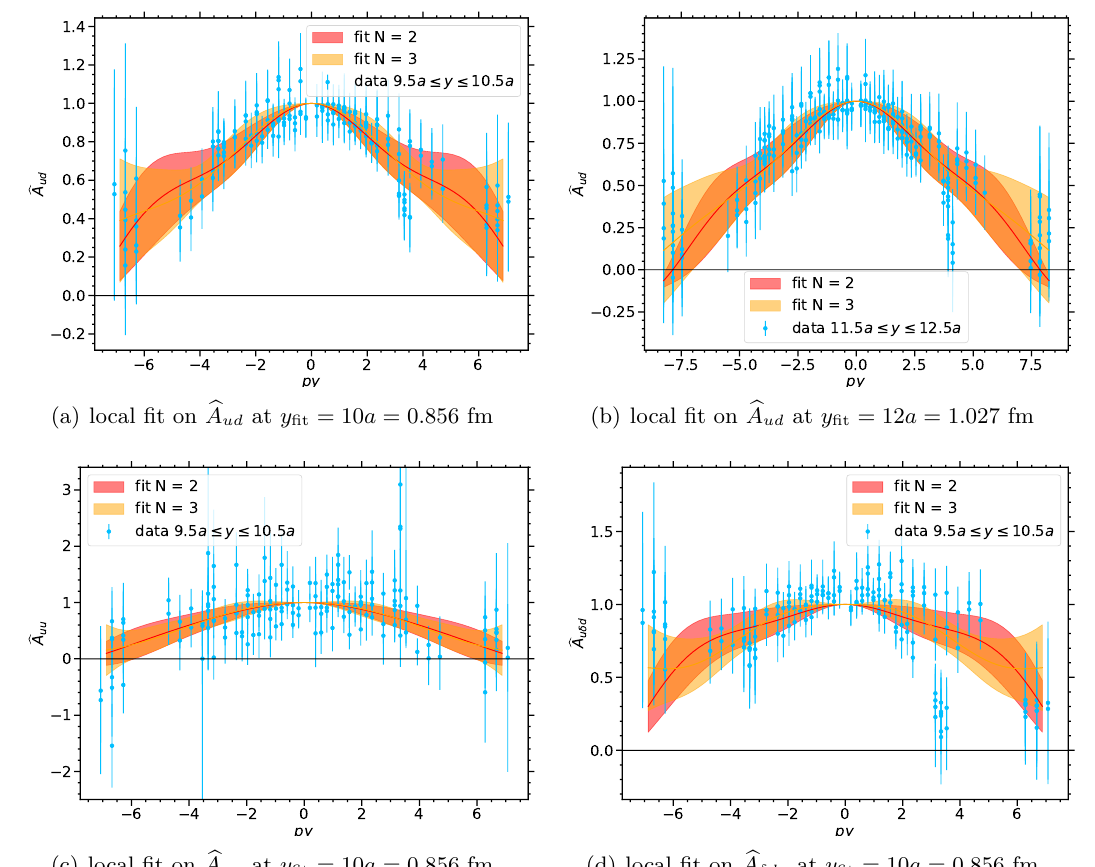
Figure 15 . py dependence of the twist-two function data and the corresponding local fits with N = 2 , 3 . This is shown for the functions b A ud at y fit = 10 a (a) and y fit = 12 a (b), as well as for b A uu (c) and b A δdu (d) both at y fit = 10 a . We plot all data points included by the fits for a given y fit , i.e. all data points in the range y fit ± 0 . 5 a (see the